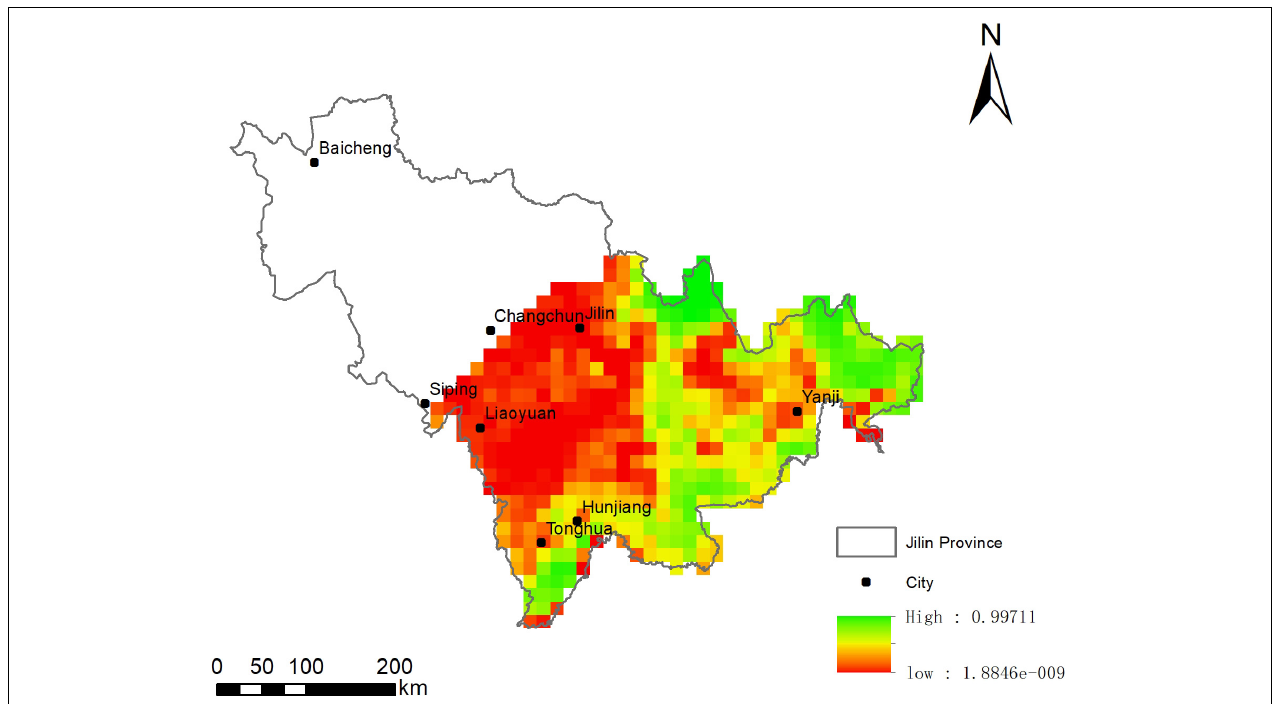
FIGURE 4 | The Asiatic Black Bear forecast distribution map in Jilin Province.